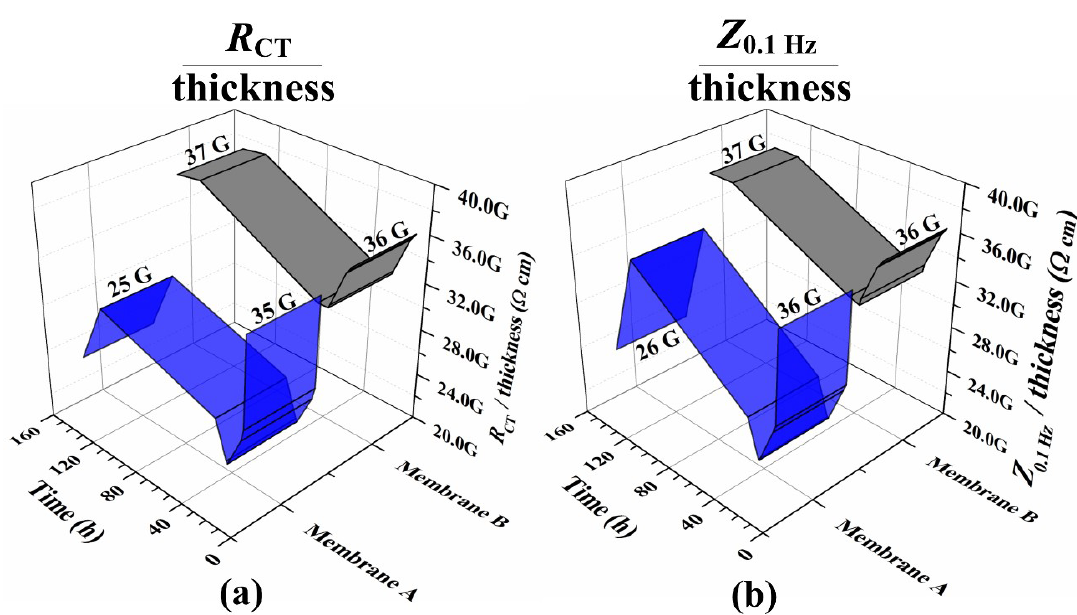
and (b) |Z| values for membranes thickness as a function of exposure time in 0.1 mol/L KCl. Blue color CT 0.01Hz